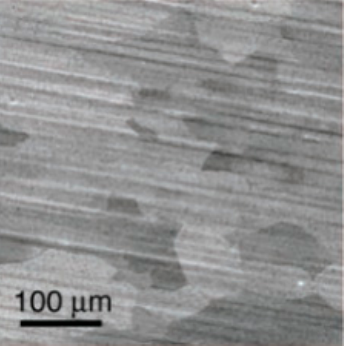
Figure 2. SEM image of graphene on a copper foil with a growth time of 30 min [34].